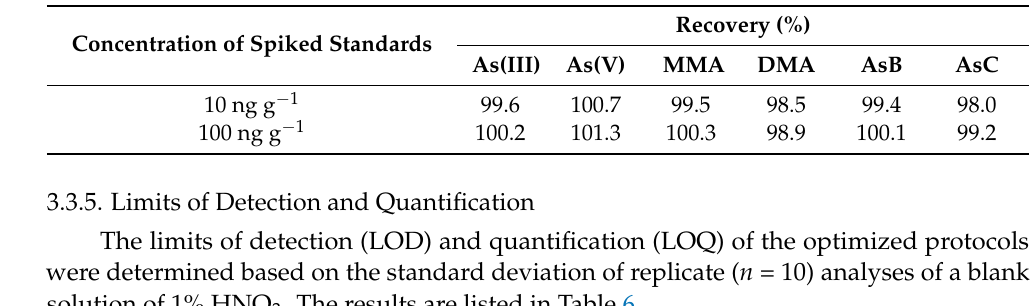
Table 5. Recoveries of As species during ultrasound-assisted enzymatic extraction.